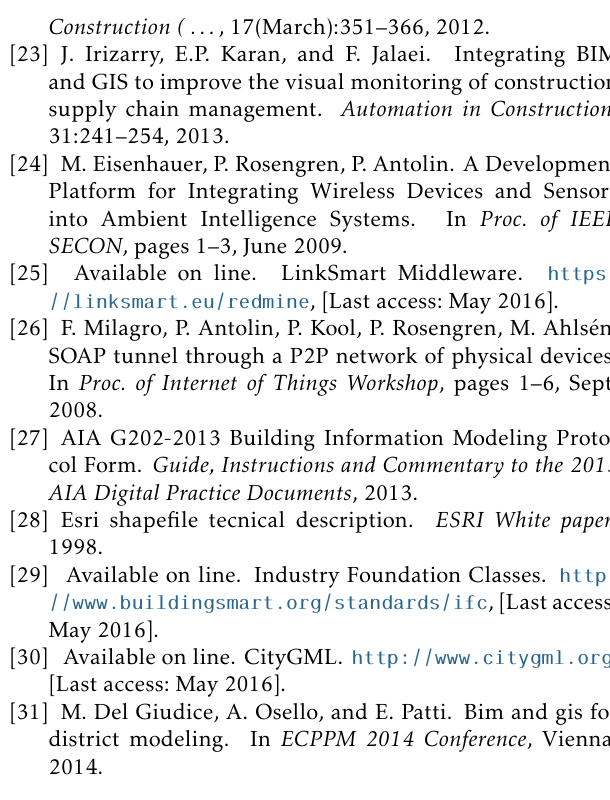
Figure 8. District data query sequence